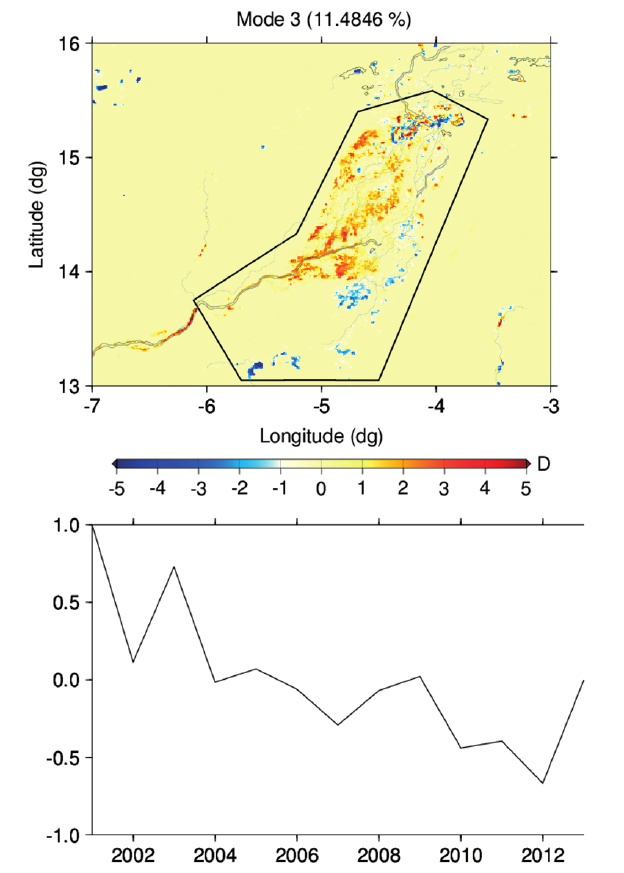
Figure 16. Empirical Orthogonal Functions (EOF) modes of Moderate Resolution Imaging Spectroradiometer open water class over the Region Of Interest